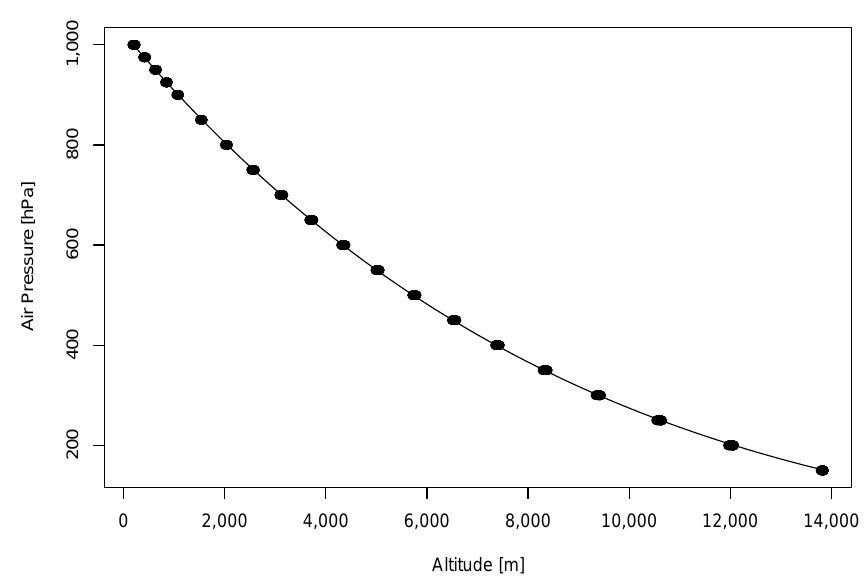
Figure 5. Points: weather data from GFS; curve: fitted non-linear regression.